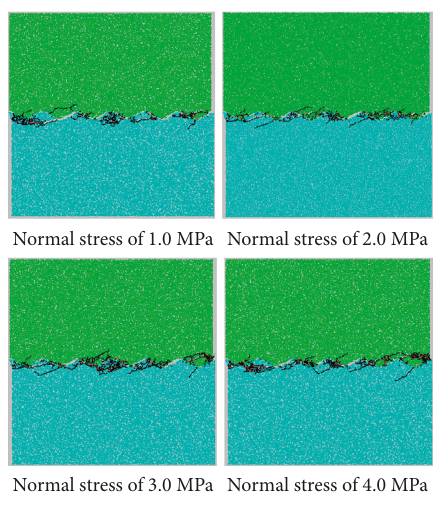
Normal stress of 3.0 MPa Normal stress of 4.0 MPa Figure 9: Failure modes for specimens with different bond strength ratios under different normal stresses: bond strength ratio of (a) 0.25, (b) 0.5, (c) 0.75, and (d) 1.0.